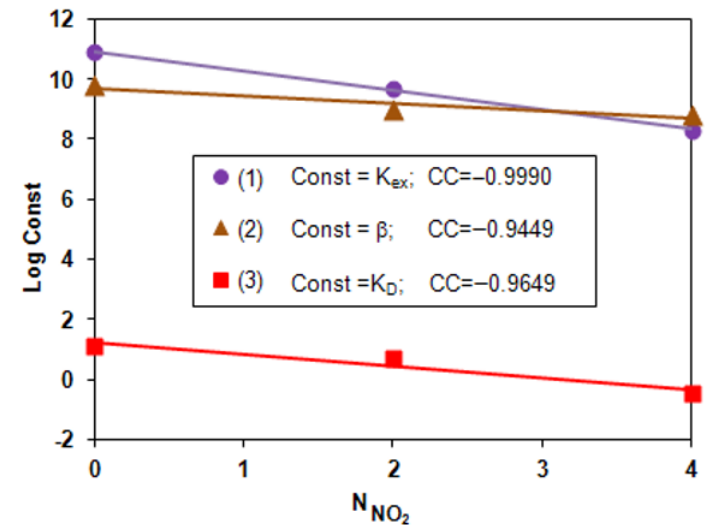
Figure 8. Negative linear relationships between Log K other hand for the extraction systems containing In(III), PAR and MBT (BT, NBT and TNBT). Straight line equations: (1) y=−0.65x+10.93; (2) y=−0.25x+9.70; (3)